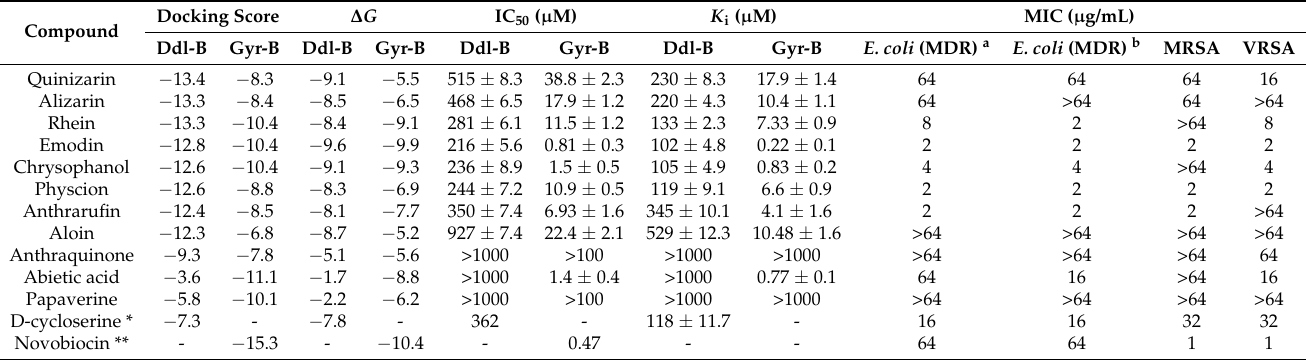
Table 1. Docking scores, ∆ G , IC 50 , K i , MIC values of top-scoring